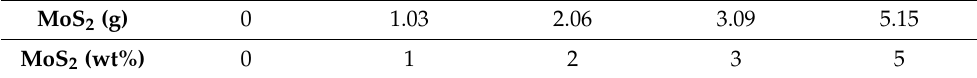
Table 3. Masses of nanoparticle additives used in film and corresponding percent by weight